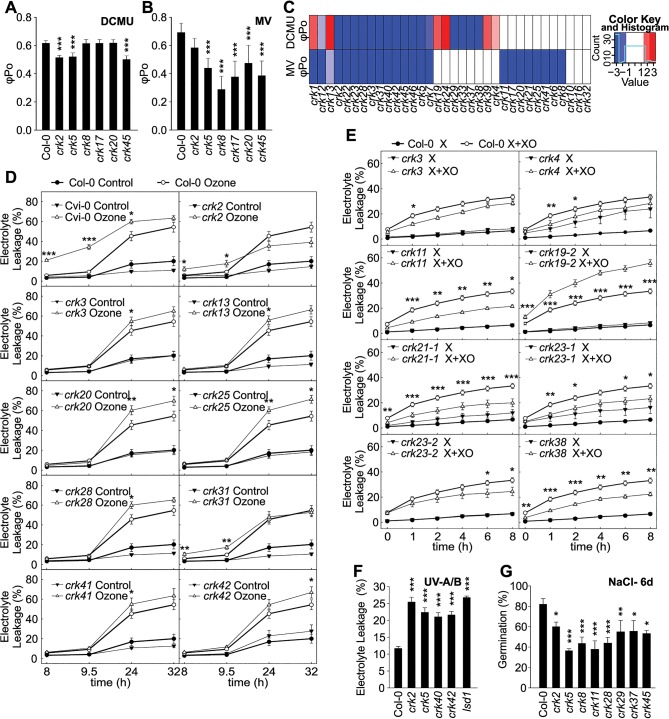
Abiotic stress responses are affected in crk mutants.
(A and B) Treatment with 3-(3,4-dichlorophenyl)-1,1-dimethylurea (DCMU) for two hours (A) or methyl viologen (MV) for 48 hours (B) resulted in stronger impairment of photosynthesis in a subset of crk mutants compared to Col-0 wild type as shown by changes in the maximum quantum yield of primary photochemistry (φ
Po). Significant differences in relation to wild type are indicated (n = 12, bars represent SD; one-way ANOVA with post hoc Tukey HSD) *** P<0.001. The experiment was repeated three times with similar results. (C) Clustering of DCMU and MV experiments. Red and blue indicate increased or decreased response with respect to Col-0, respectively (average of alleles). Color intensity is proportional to a Benjamini-Hochberg false discovery rate (FDR) adjusted Z statistic, which takes the estimated means and their variation into account. Roughly, |Z|>2 corresponds to an FDR<5%, and |Z|<2.6 to an FDR<1%. Results were clustered using a complete linkage algorithm with 1-Pearson correlation as distance. (D) In several crk mutant lines exposure to O3 resulted in elevated electrolyte leakage. Electrolyte leakage was measured at indicated time points after start of the O3 exposure that lasted 6 h (350 ppb). Mean values ± SD from two independent experiments are presented (n = 12, one-way ANOVA with post hoc Tukey HSD). (E) Xanthine-Xanthine Oxidase (X+XO) infiltration induced different levels of electrolyte leakage in crk mutants compared to wild type (0.1 U ml-1, 4 h). Mean values ± SD from three independent experiments are presented (n = 16, linear model with single-step p-value adjustment for multiple testing). (F) Treatment with ultraviolet-A (UV-A) and–B (UV-B) radiation led to increased electrolyte leakage in crks compared to wild type. Mean values ± SD from three independent experiments are presented (n = 12, one-way ANOVA with post hoc Tukey HSD). (G) Effect on NaCl on the germination crk seedlings at 6 days after stratification. Values represent mean of the ratio (germination percentage on 120 mM NaCl / percentage on control medium) for each line (n = 15, linear model, single-step p-value adjustment). Experiments were performed three times. Asterisks indicate statistically significant differences between crks and Col-0 (*P<0.05, **P<0.01 and ***P<0.001) (D-G). Error bars indicate ± SE (D, E and F). Relative electrolyte leakage was calculated as a ratio of the value measured at the indicated time and the total electrolyte leakage after freezing (D and E) or autoclaving the samples (F).